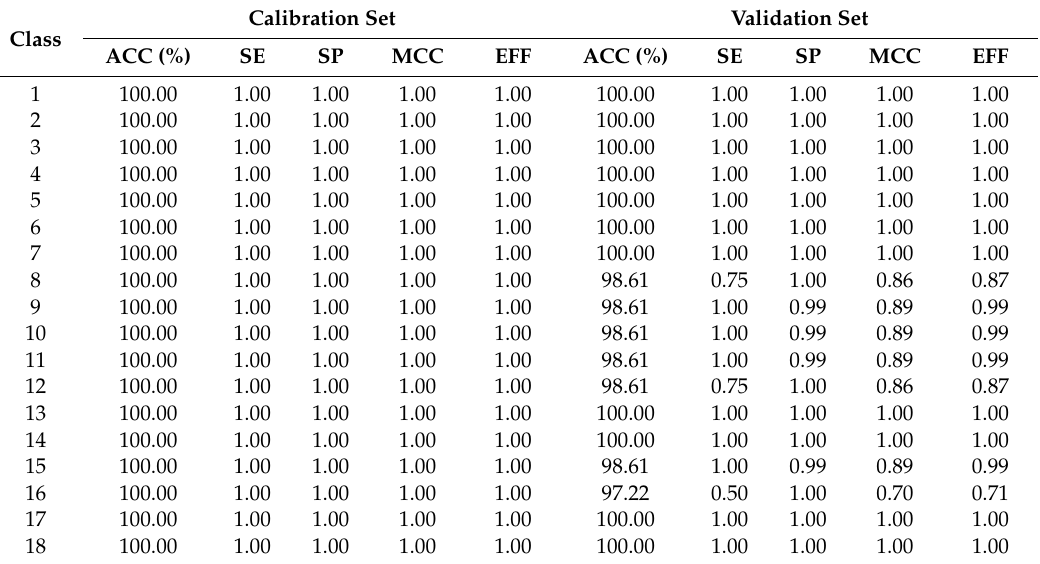
Table 2. The major parameters of RF model based on FT-MIR full spectra